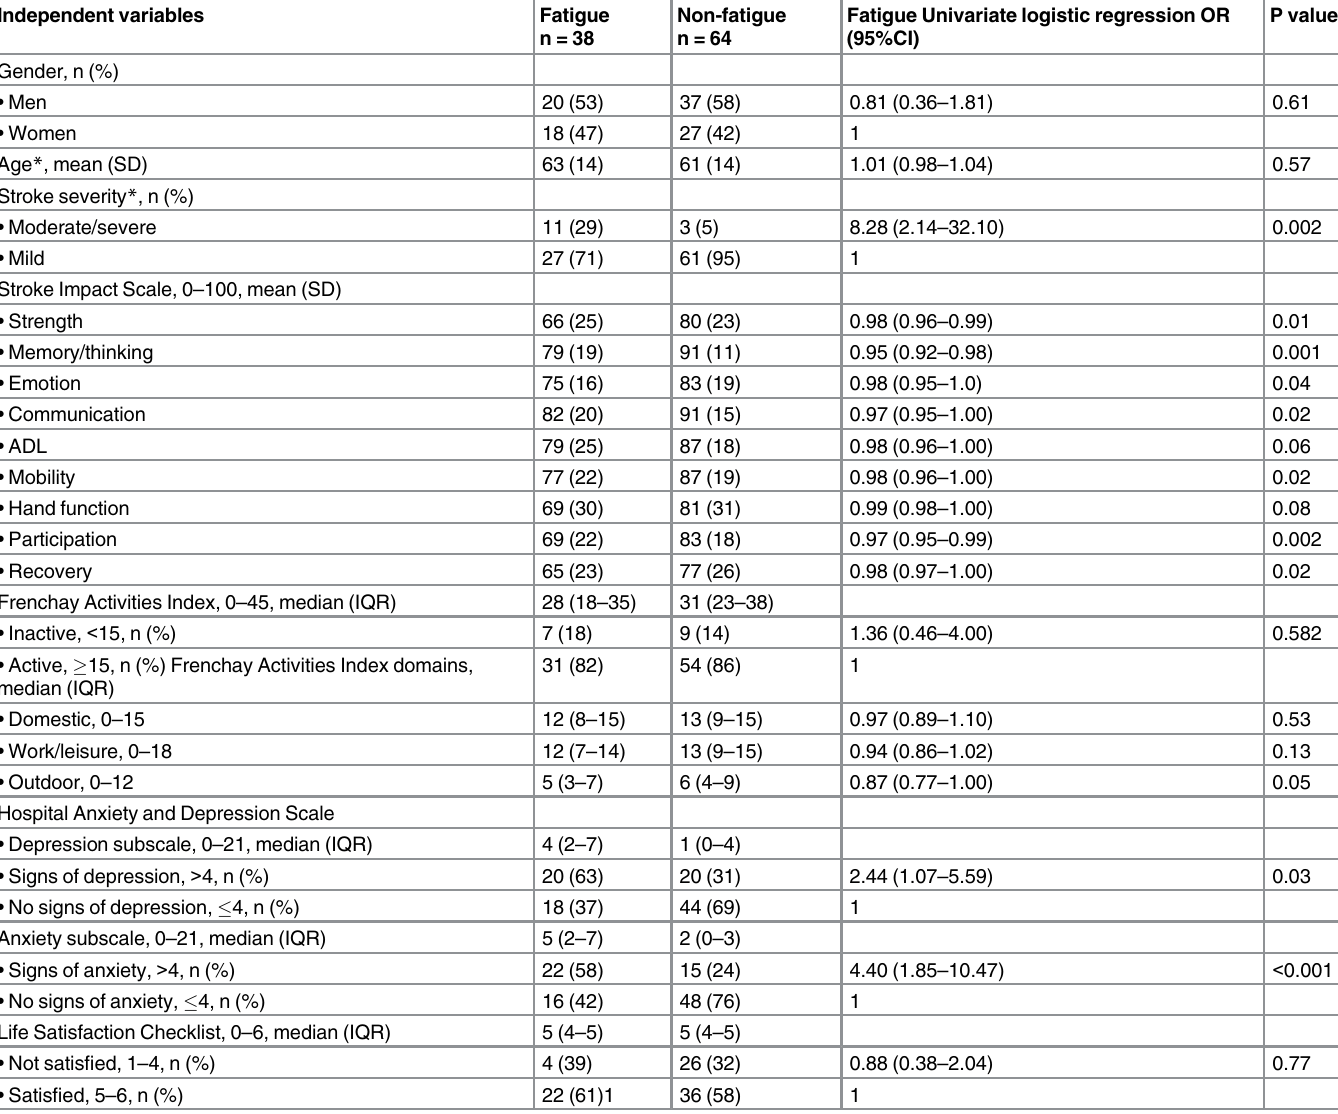
Table 2. Characteristics of persons who have had stroke, categorised according to the presence or absence of fatigue and univariable logistic regression for the association between the independent variables and fatigue, odds ratios (OR), 95% confidence intervals (CI) and p